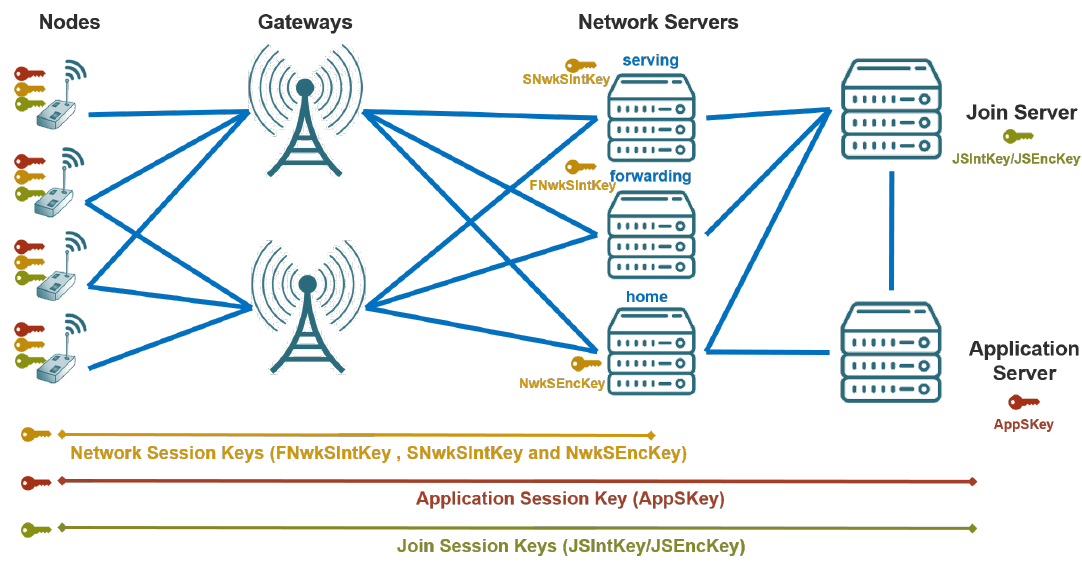
Figure 2. An overview of LoRaWAN v1.1 key